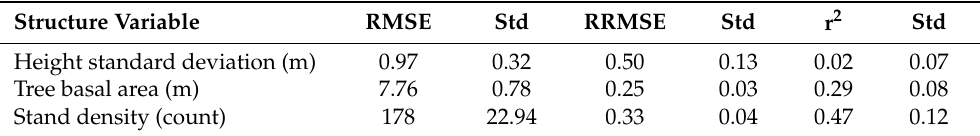
Table 8. Model accuracy metrics of additional structural attributes extracted from the forest inventory. The structural diversity model comprising all 31 predictors has been